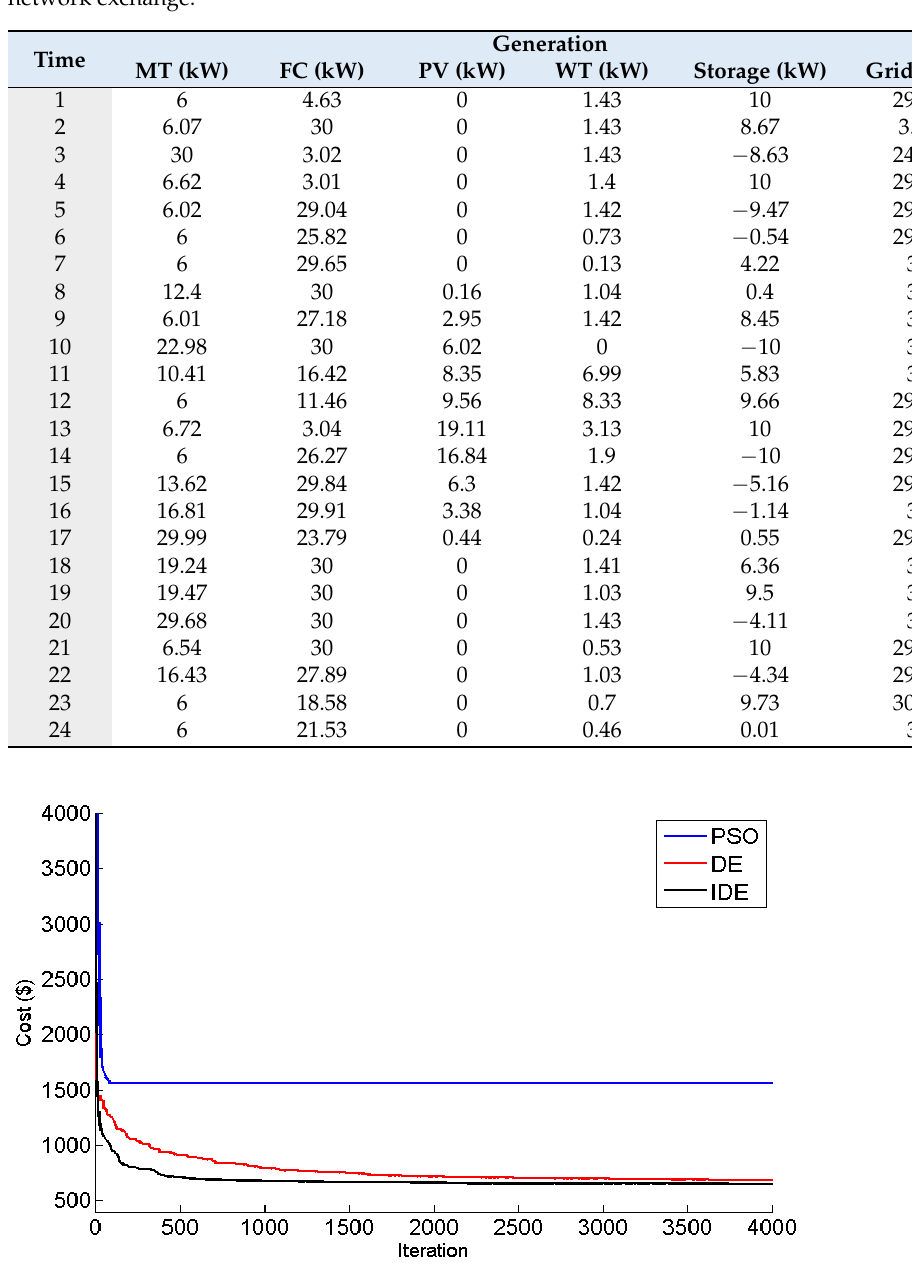
Figure 4. Cost convergence in different methods considering the limitations of power exchange with upstream network.